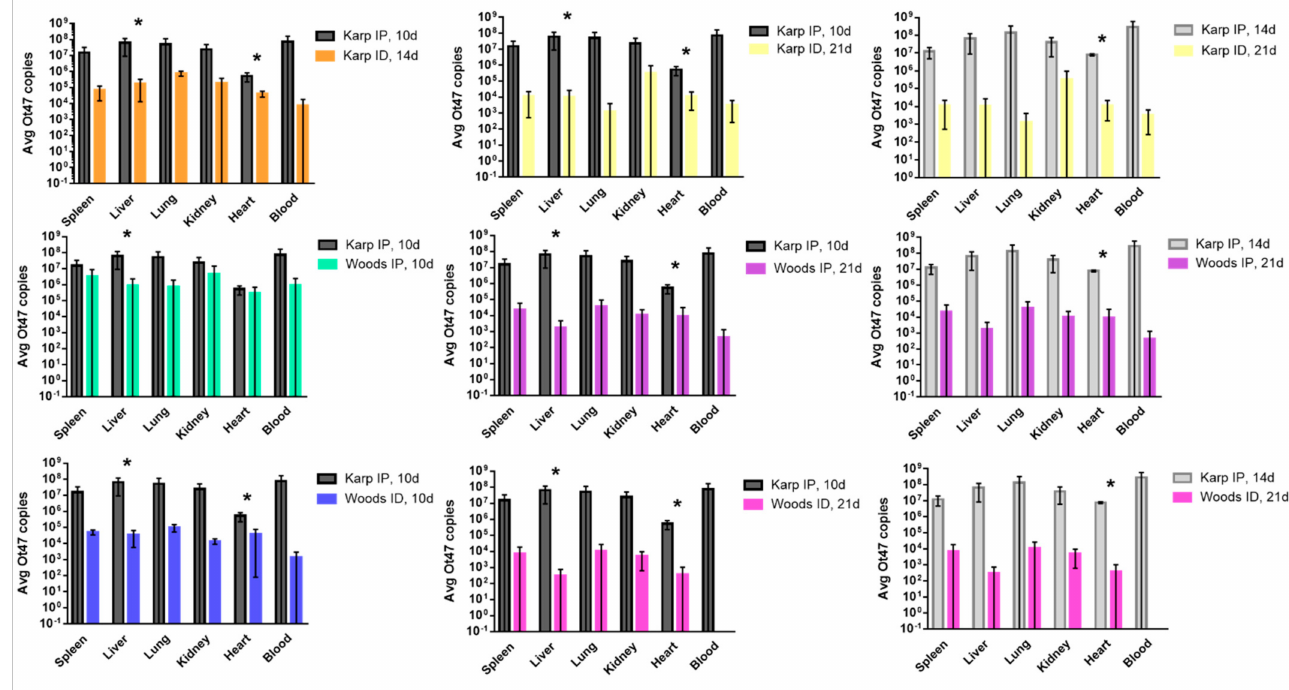
Figure 3. Bacterial trafficking of O. tsutsugamushi in the lethal (Karp IP) and nonlethal (Karp ID, Woods IP, Woods ID) models of O. tsutsugamushi infection at 10, 14, and/or 21 dpi. Significant differences between average bacterial loads in the lethal and nonlethal models are indicated by asterisks (*, p <